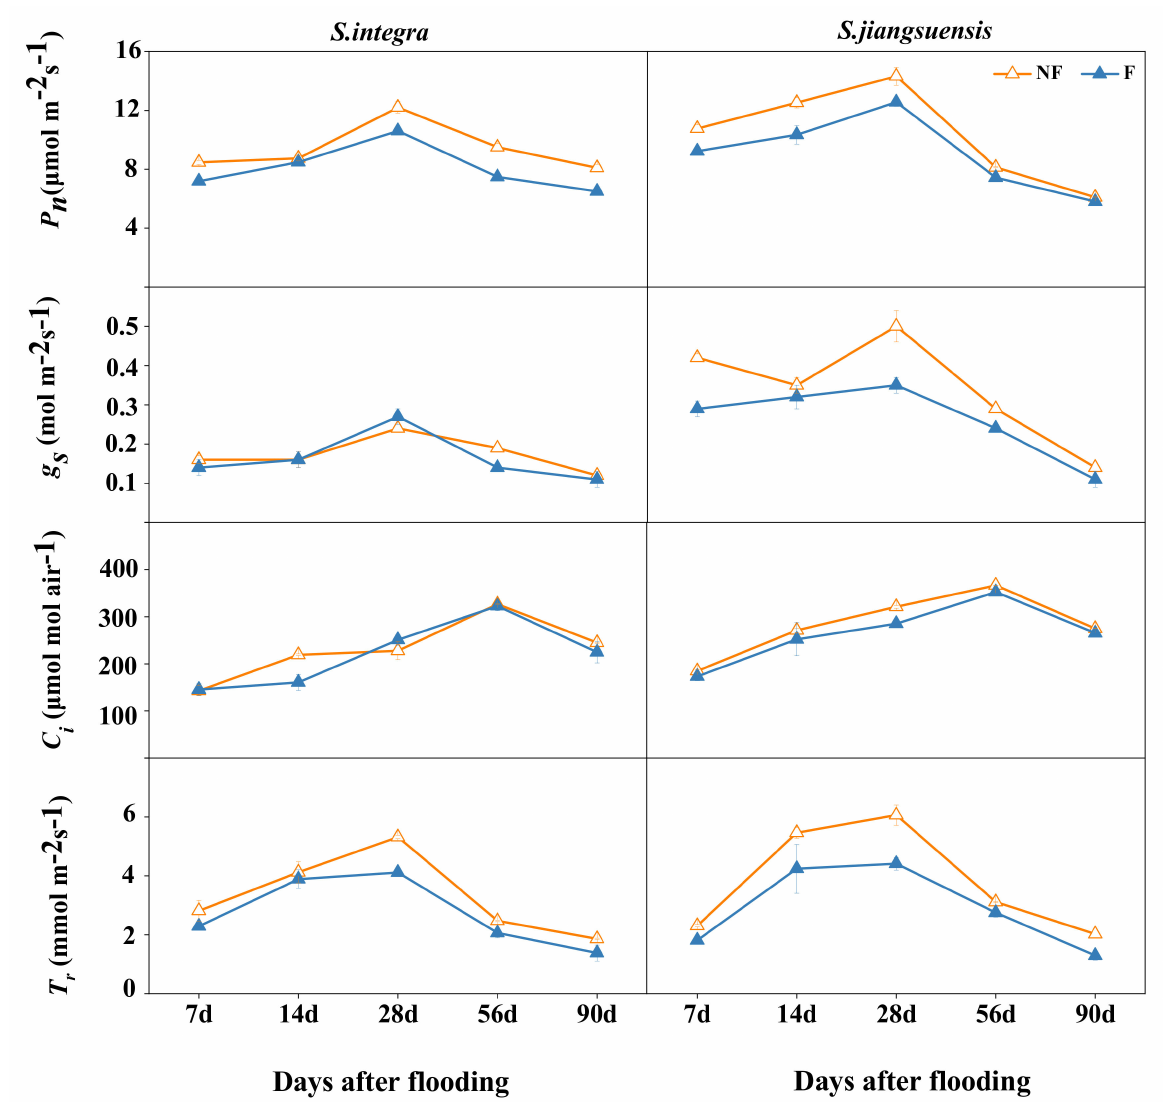
Figure 1. Temporal changes in photosynthetic rate ( P n , µ mol.m − 2 s − 1 ), stomatal conductance ( g s , mol H 2 O m − 2 s − 1 ), intercellular CO 2 concentration ( C i , µ mol CO 2 mol air − 1 ), and transpiration rate ( T r , mmol H 2 O m − 2 s − 1 ) in leaves of S. integra and S. jiangsuensis exposed to Cu-contaminated soil under non-flooded (NF) and flooded (F) conditions for 90